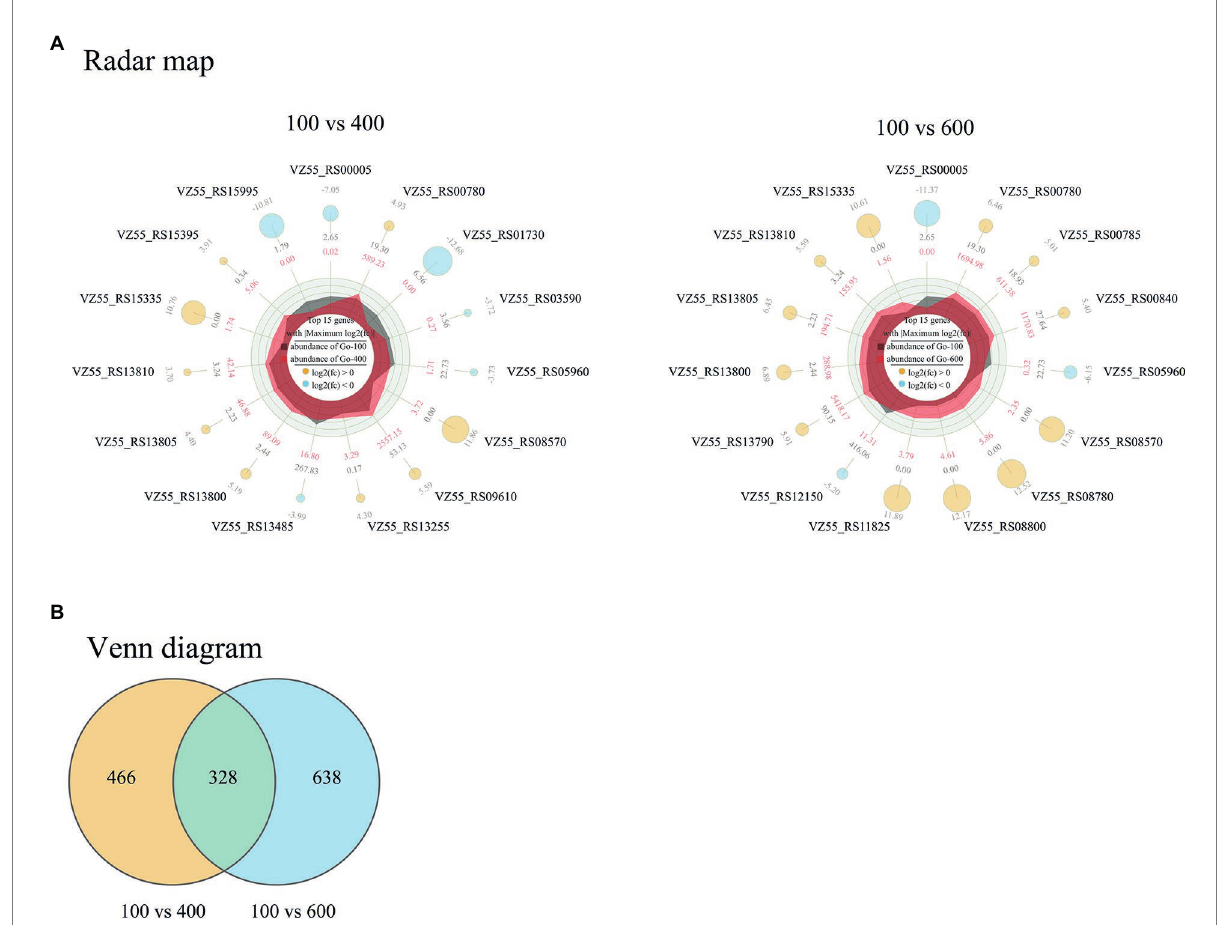
FIGURE 7 Radar map (A) and Venn diagram (B) of DEGs in G. oxydans responding to extra-high titers of glucose (400 and 600 g/L) with 100 g/L as control. The filter criteria of DEGs were q < 0.05 and |log 2 FC| > 1. A parallel experiment was conducted in triplicate. (A) The outermost circle are the gene name and log 2 FC; the yellow and sky-blue circle represent up-regulated and down-regulated genes, respectively, and the size of the circle represents the size of the log 2 FC value; outer data of third circle represents the average expression amount of the initial 100 g/L glucose and inner data of third circle represents the average expression amount of the initial 400 g/L (or 600 g/L) glucose; the irregular shapes in the circles are the expression abundance on each axis for initial 100 g/L glucose and initial 400 g/L (or 600 g/L) glucose; the innermost circle center indicates the